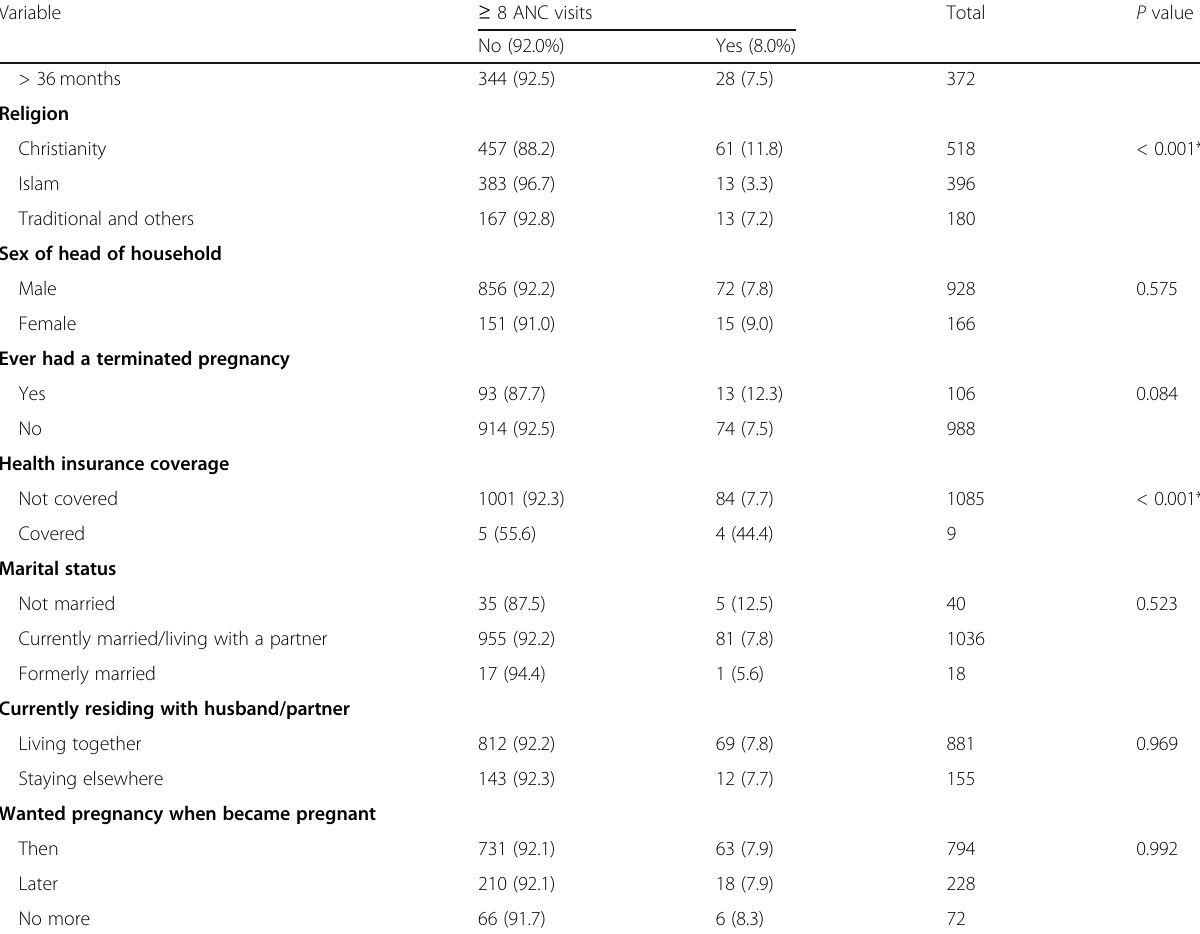
Table 1 Characteristics of women attending ≥ 8 ANC contacts in Benin, West Africa, BDHS 2017 – 18 (Continued) Variable